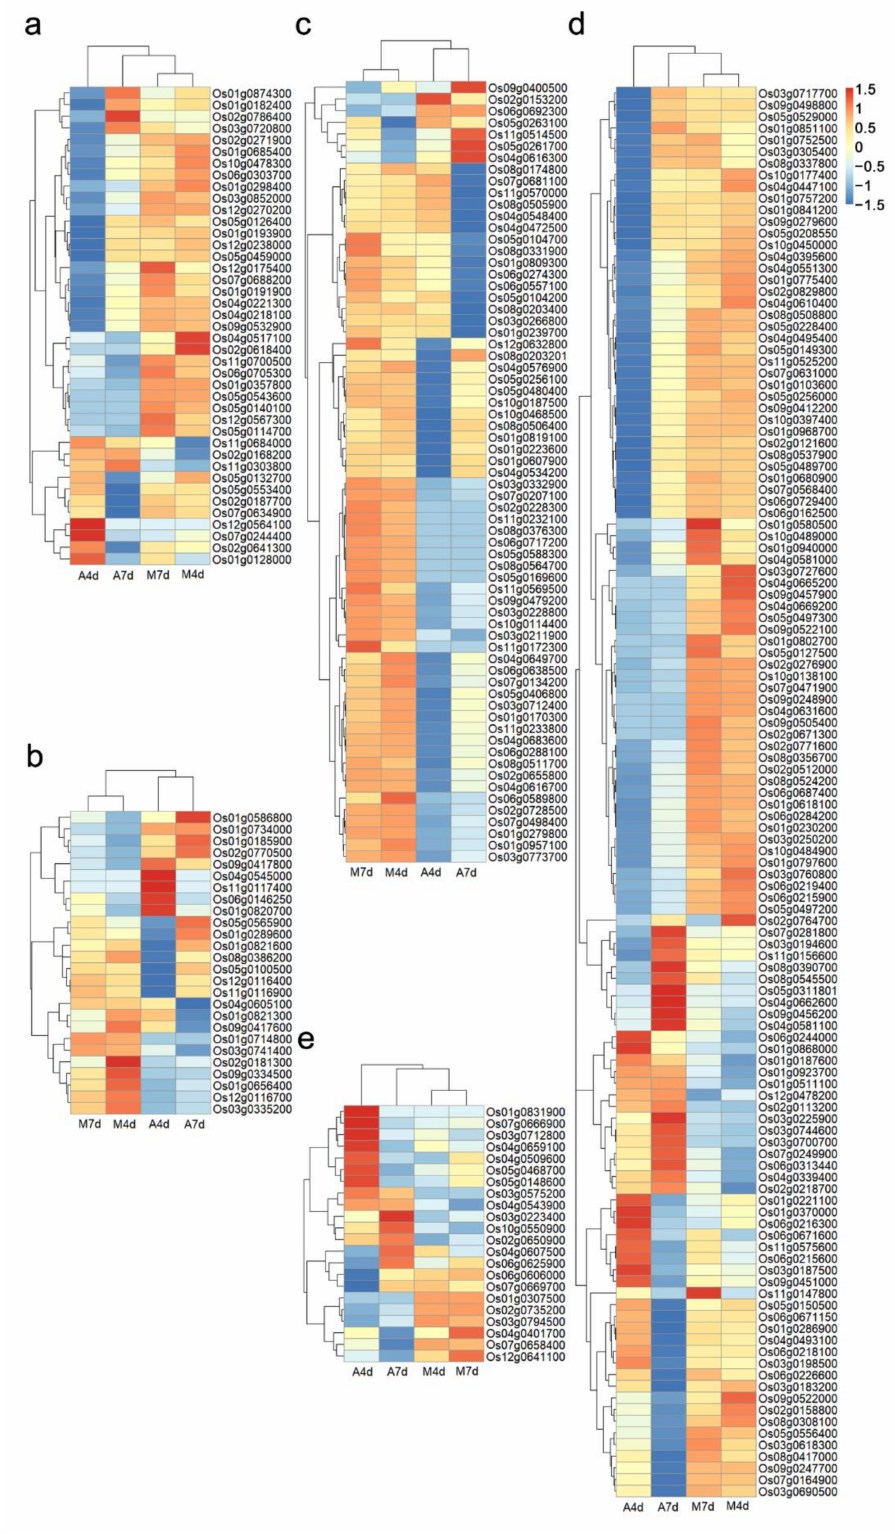
Figure 6. A number of Transcription factor-, leucine rich repeats- and Hormone signal-related DEGs in M4d, M7d, A4d and A7d. ( a ) Expression pattern of 41 MYB transcription factor-related genes. ( b ) Expression pattern of 26 WRKY transcription factor-related genes. ( c ) Expression pattern of 67 leucine rich repeats-related genes. ( d ) Expression pattern of 121 hormone signal transduction- related genes. ( e ) Expression pattern of 22 ionic pressure-related